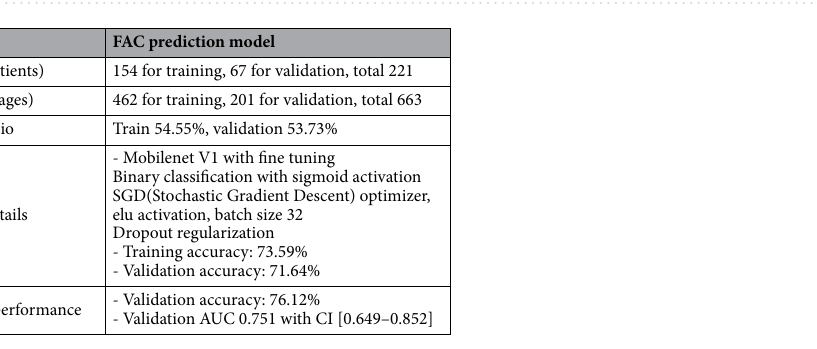
Table 2. Performances of the deep-learning model. ML machine learning, FAC functional ambulation category, DNN deep neural network, SGD stochastic gradient descent, AUC area under the curve, CI confidence